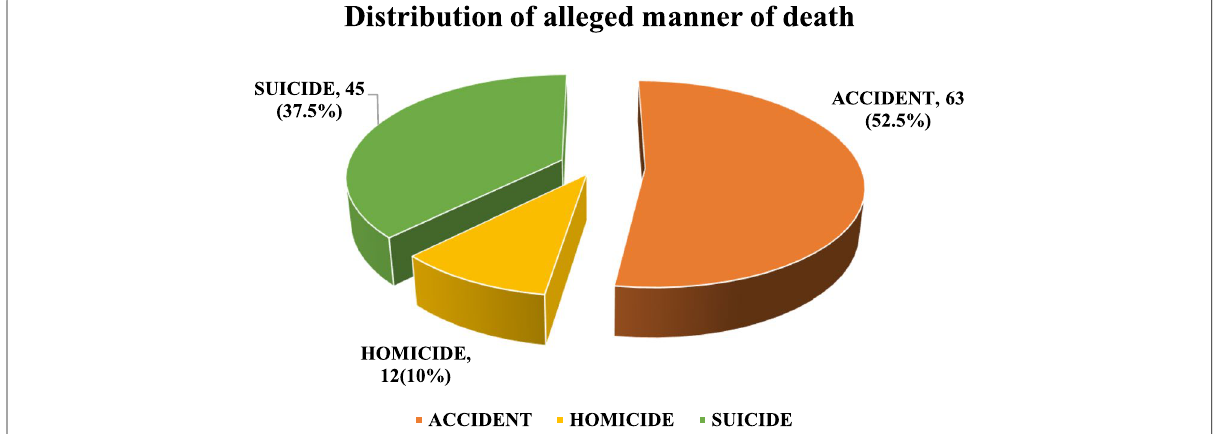
Fig. 4 Distribution of alleged manner of death